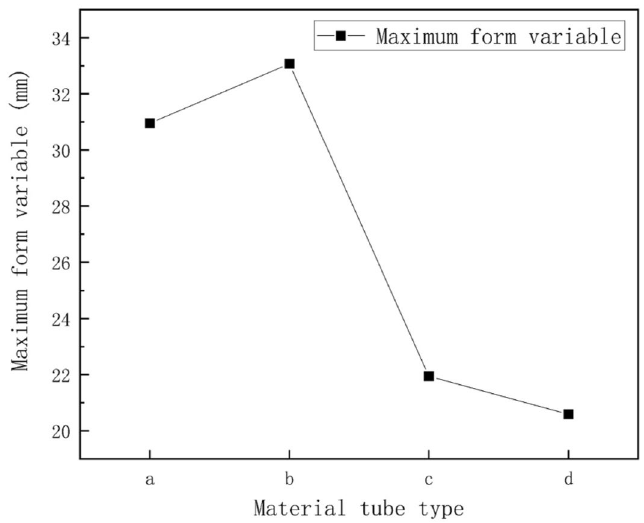
Figure 9. Linear graph for skeleton shape variation under uniform snow load condition: ( a ) round tube; ( b ) square tube; ( c ) Ω tube; ( d ) elliptic tube.